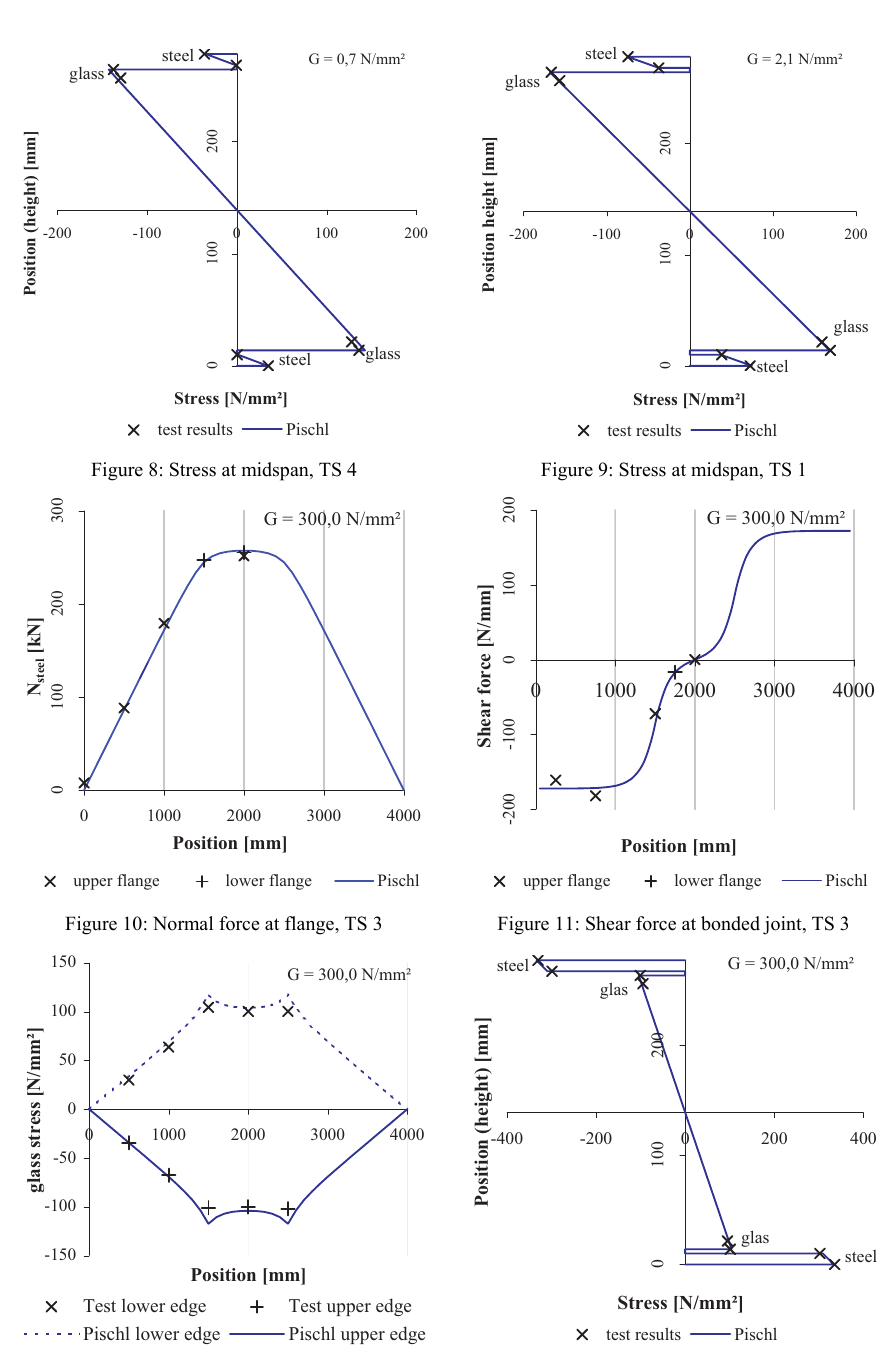
Figure 12: Glass stress, TS 3 Figure 13: Stress at midspan, TS